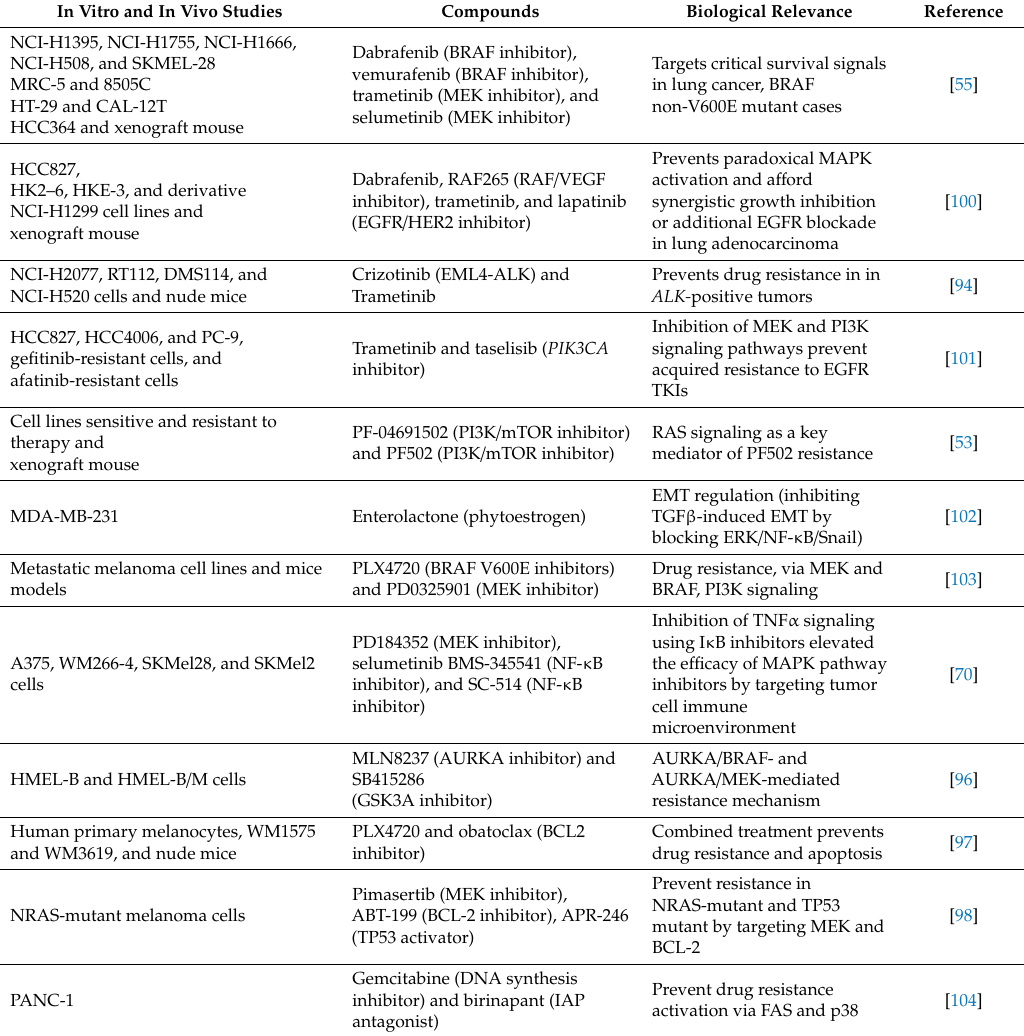
Table 2. In vitro and in vivo testing of the e ff ects of MAPK